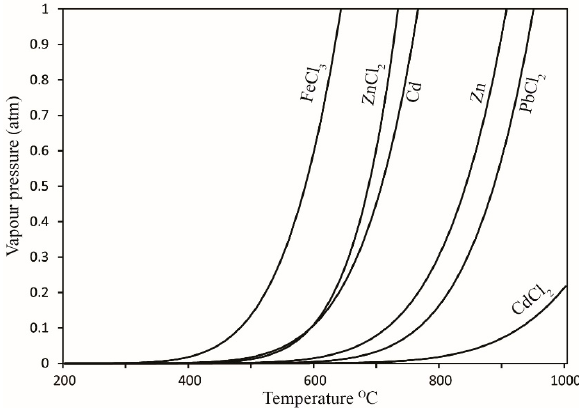
Figure 4. The vapor pressure changes with temperature.